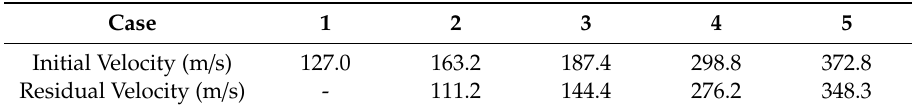
Figure 4. Perforations through 10 mm 7075-T651 plates showing residual velocities of ( a ) 91.5, ( b ) 128.2, ( c ) 218.1, and ( d ) 301.2 m/s by projectiles at initial velocities of ( a ) 200.9, ( b ) 215.5, ( c ) 264.9, and ( d ) 346.8 m/s. Table 2. Initial and residual velocities of projectiles ( t pl = 5 mm).